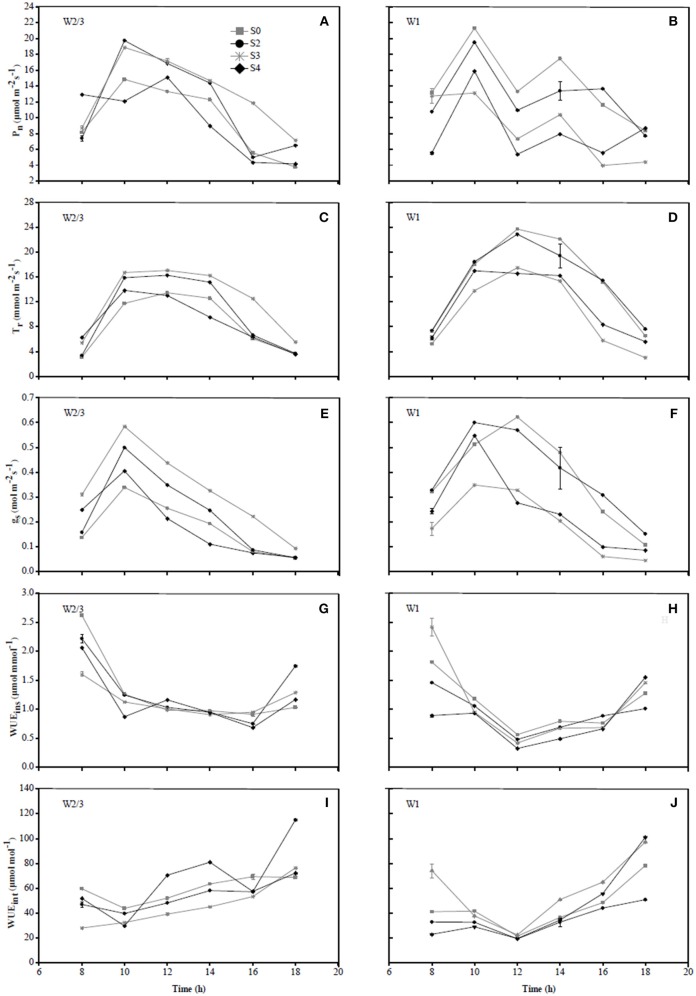
Diurnal variations in photosynthetic rate (Pn) (A,B), transpiration rate (Tr) (C,D), stomatal conductance (gs) (E,F), instantaneous water use efficiency (WUEins) (G,H), and intrinsic water use efficiency (WUEint) (I,J) of tomato under different water treatments at fruit ripening stage (date 07/11) in 2017.